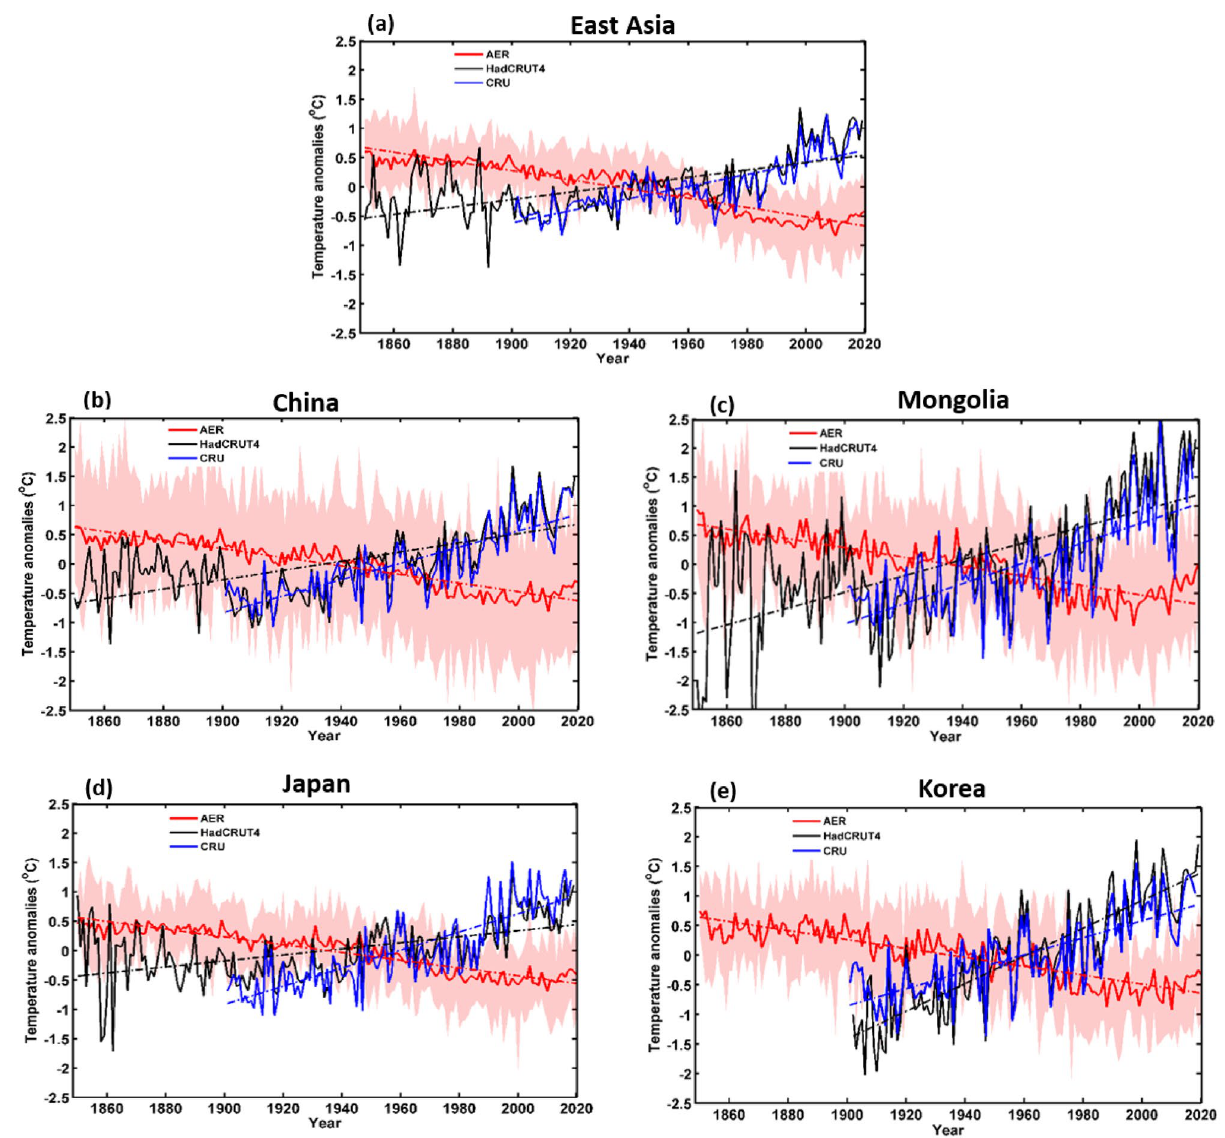
Figure 5. As for Fig. 3 but showing temperature anomaly responses to aerosol (AER)